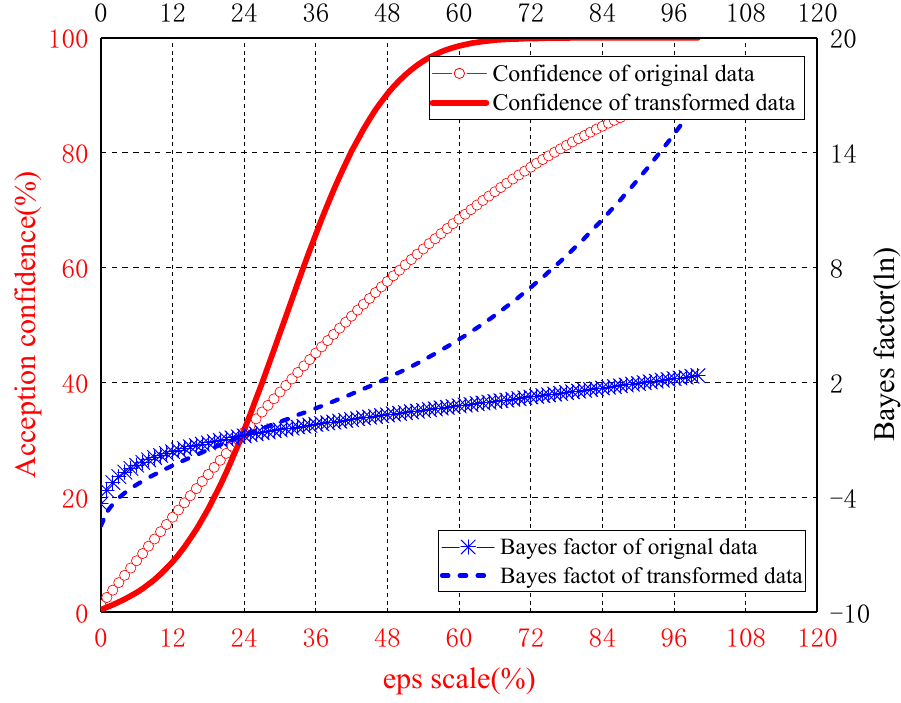
Figure 8. Effect of various ɛ values for the calibrated model with original and transformed data.